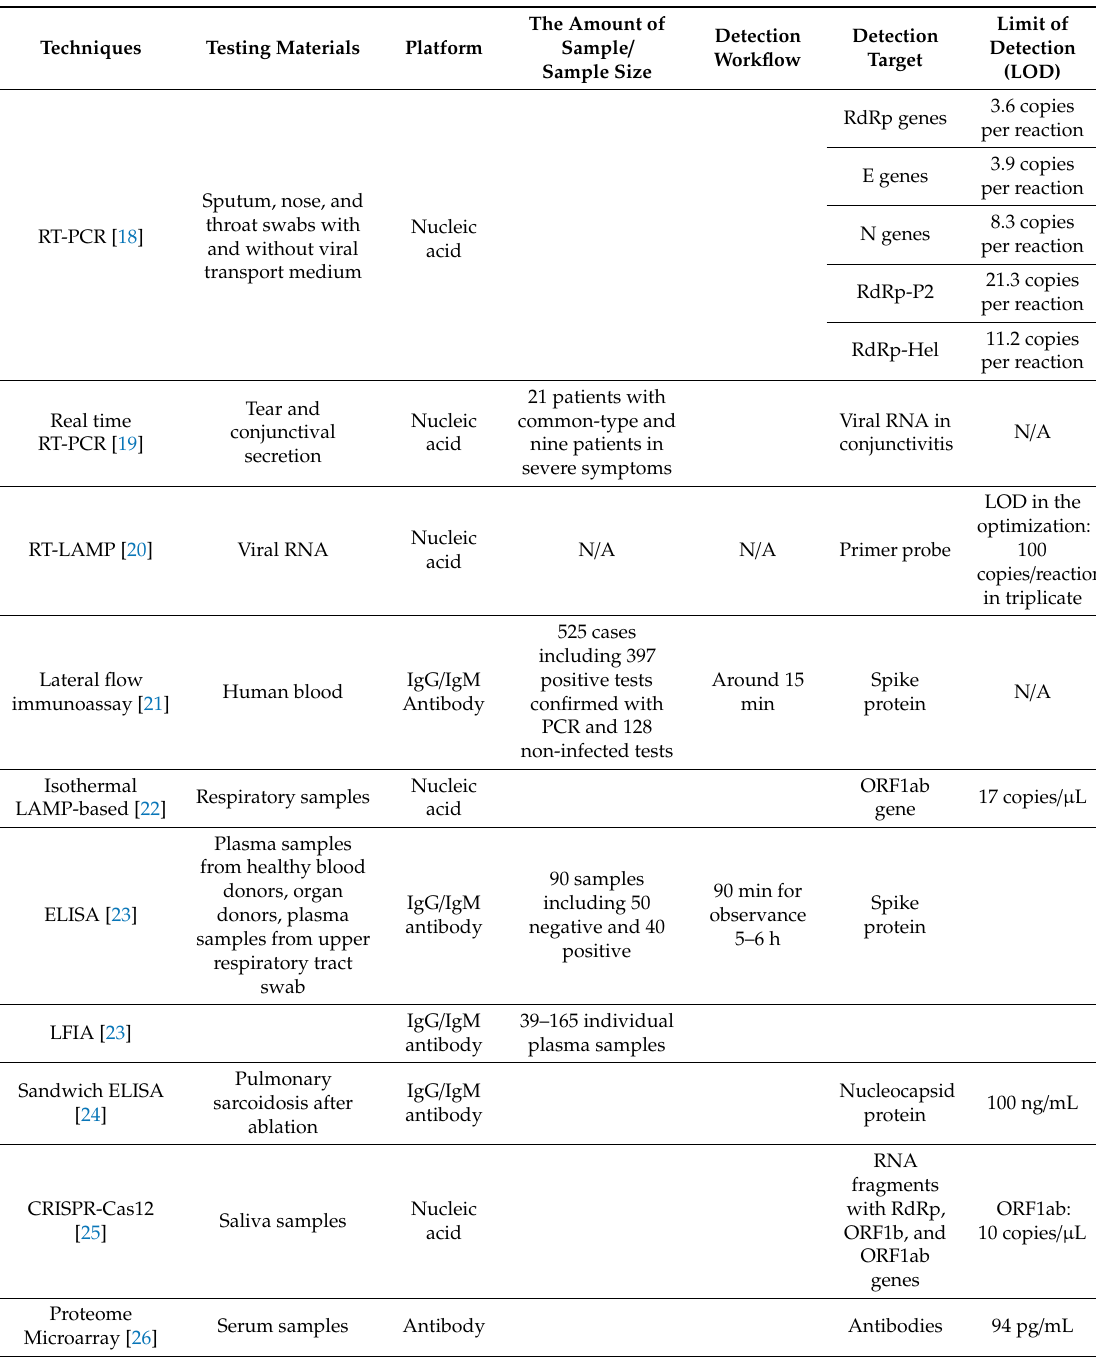
Table 1. Available laboratory-based molecular, serological, and immunological diagnostic test for the severe acute respiratory syndrome coronavirus-2